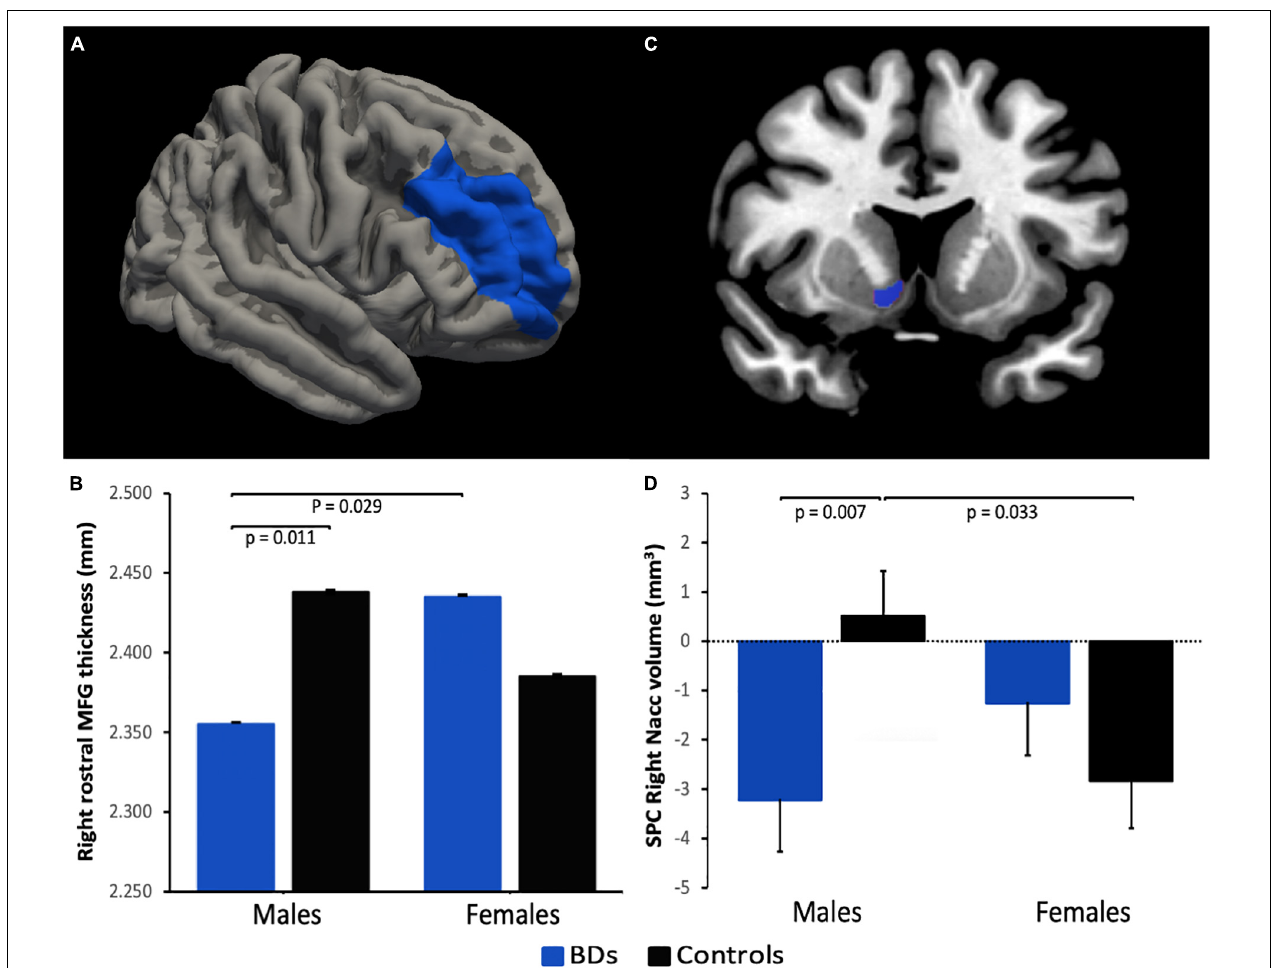
FIGURE 3 | Region of interest (ROI) analysis. (A,C) Areas in blue illustrate the brain labels (derived from FreeSurfer atlases) used to define ROIs. (B,D) Bar graphs represent significant group by sex interactions in rostral middle frontal gyrus (MFG) thickness at follow-up and right nucleus accumbens (NAcc) volume across time (i.e., symmetrized percent change, SPC), respectively. Errors bars represent the standard error of the mean. NAcc image is displayed in radiological convention (i.e., left is right).